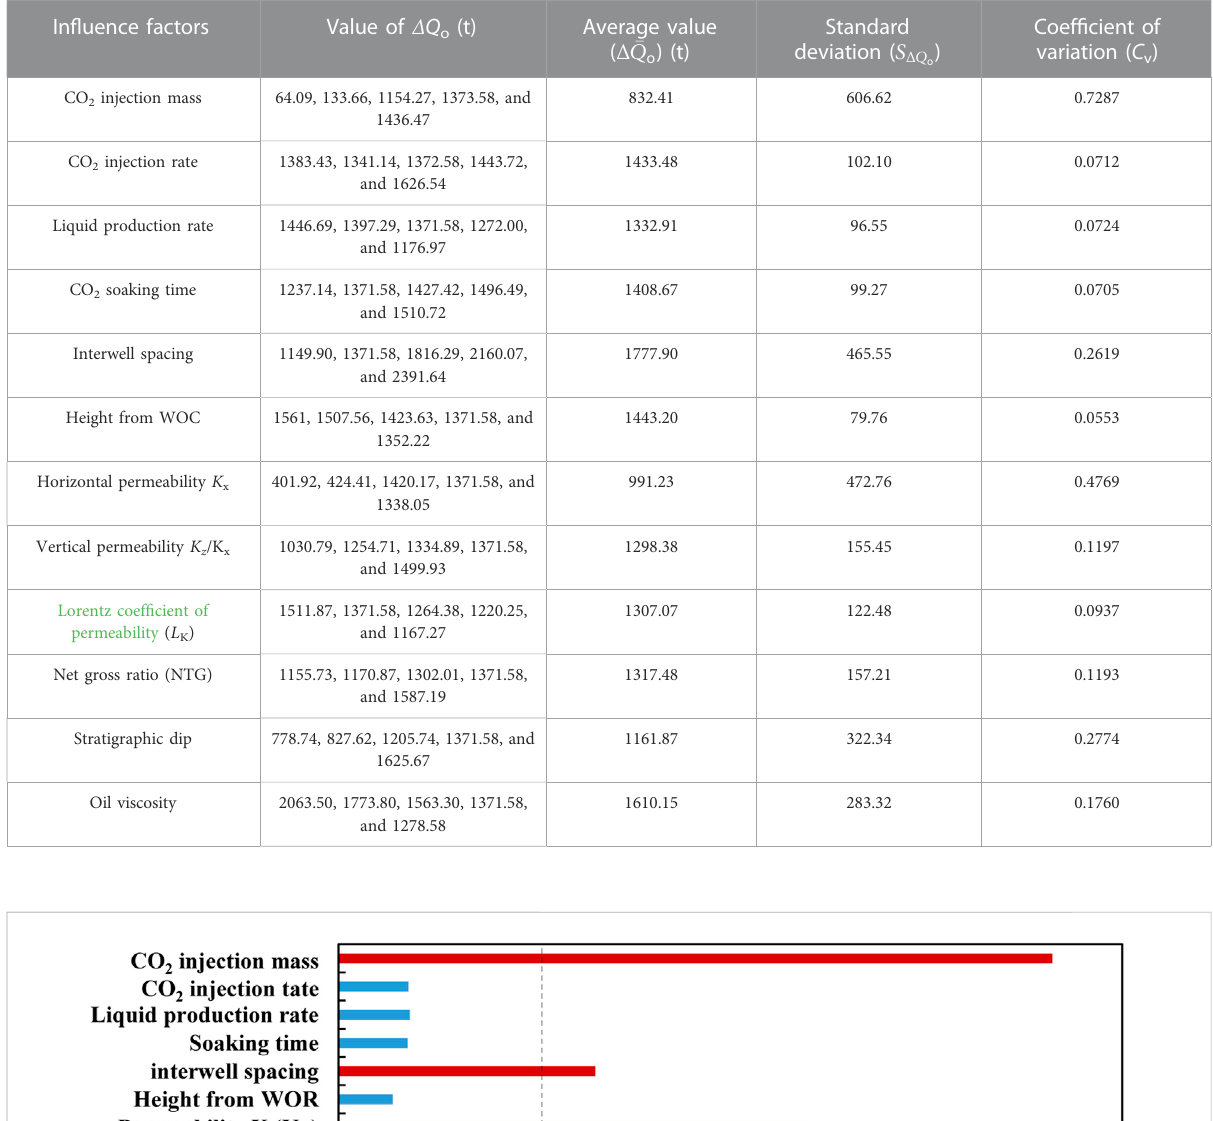
TABLE 7 Simulation results and sensitivity analysis of well-to-well interplay during CO 2 huff-n-puff.